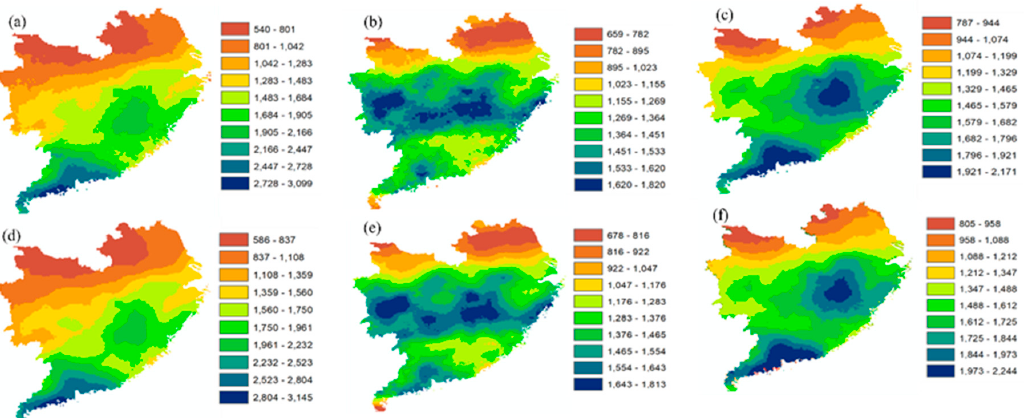
Figure 8. Comparison between the downscaled weighted precipitation at 0.05° resolution for ( d )( e )( f ) and the original GPM precipitation at a nominal resolution of 0.1° for ( a ) the dry year (2001), ( b ) the wet year (2004), and ( c ) the average annual (2001–2015), respectively. Subsequently, to analyze difference in the range of precipitation classes (i.e., difference between the upper and the lower boundary of captured precipitation pattern) between the original dry year (2001), the wet year (2004) and the average annual (2001–2015) precipitation at 0.1° resolution, their corresponding weighted precipitation at 0.05° resolution was found to be in close proximity with the average difference of less than 5 mm for most classes. Apart from that, EDBF algorithm slightly underpredicted extreme precipitation for the dry year (2001) and the wet year (2004) with the average difference of 30 mm, and overpredicted the average annual (2001–2015) precipitation with a difference of 20 mm. On the contrary, for low precipitation EDBF underpredicted the dry year (2001) and the average annual (2001–2015), and overpredicted the wet year (2004) precipitation with the average difference of 10, 4 and 23 mm, respectively. Similarly, considering the individual precipitation variable, EDBF accurately predicted the wet year (2003) and the average annual (2001– 2015) precipitation with the average difference of less than 5 mm, whereas it slightly overpredicted the dry year (2001) with an average difference of 10 mm between the original and the corresponding weighted precipitation. Table 6. The comparison of spatial pattern between the GPM-based precipitation with its corresponding weighted precipitation for different precipitation classes. Variables